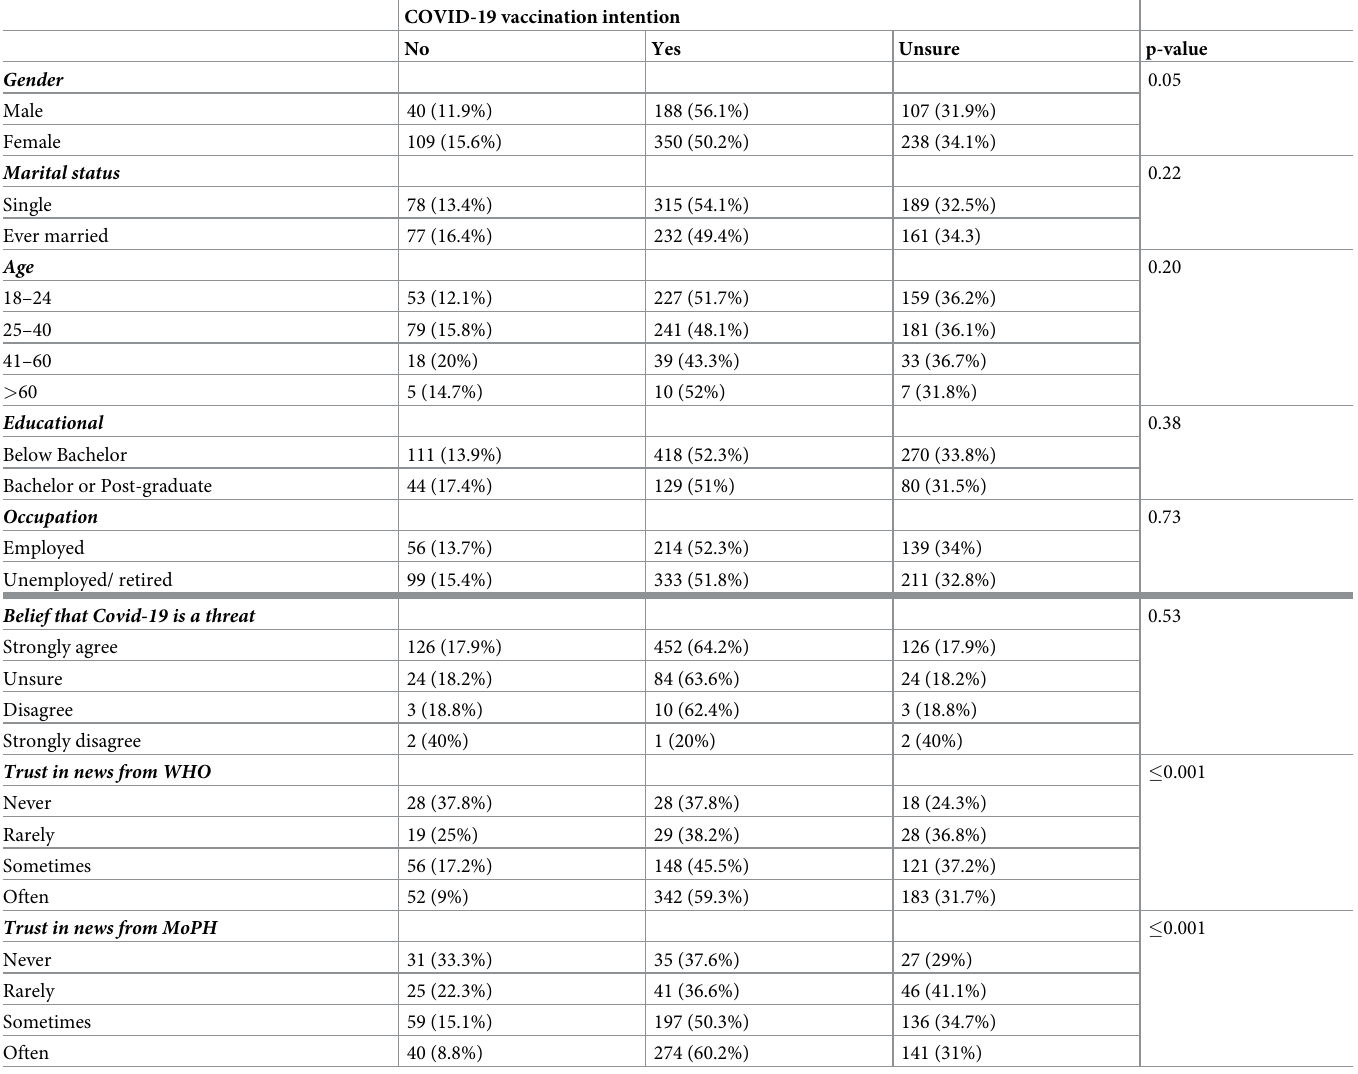
Table 2. Vaccination intent vs. socio-demographic and social media exposure and use-related